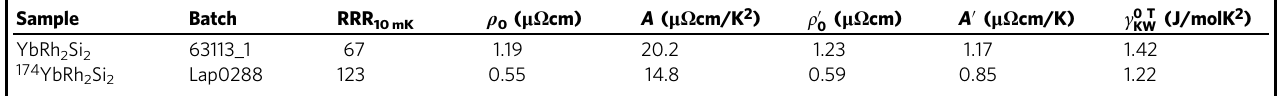
Both samples are from batches studied in detail previously 17,32 . Their residual resistance ratios RRR 10mK = R (300K)/ R (10mK), as well as the zero- fi eld Fermi liquid behavior ρ = ρ 0 + AT 2 below T N and the non-Fermi liquid behavior ρ ¼ ρ 0 0 þ A 0 T at the quantum critical fi eld of 60mT con fi rm high sample quality. To remove uncertainties in the geometric factors, we have assumed ρ (300K) = 80